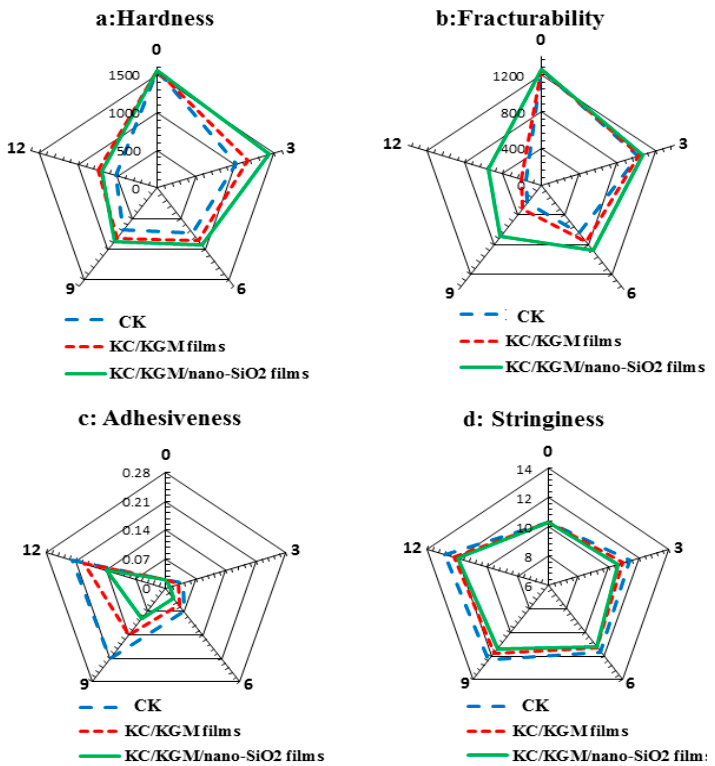
Figure 7. Effects of Agaricus bisporus on sensory evaluation by using different treatments during the storage period.